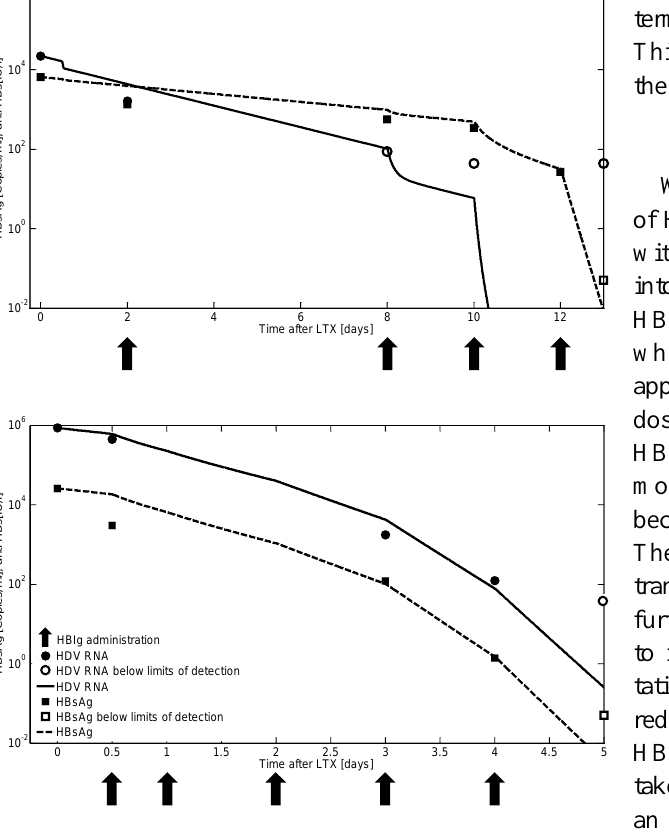
Fig. 2. Fitting results of representative